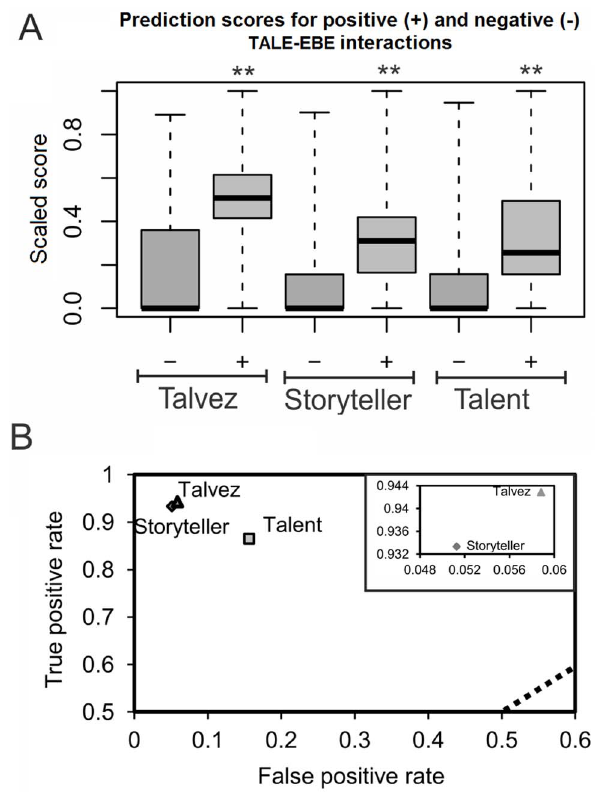
Figure 1. Performances of the EBE prediction software in the TALE-EBE validation set. ( A ) Boxplot showing the median (thick line), the lower and upper quartiles (box) and the minimum and maximum (whiskers) of the prediction scores for the set of positive ( + ) and negative ( 2 ) control TALE-DNA interactions using three programs for EBE prediction. Scores were scaled down according to the maximum score on the set to facilitate comparison. Talent scores were scaled x 2 1 since they follow an inverse scale relative to the other programs, this transformation maintains data structure. ** Indicates significant positive vs. negative differences (one-tailed t-test p-value , 0.001). ( B ) ROC graph showing the true positive and false positive rate of the three EBE predictors based on validation set screenings. Dashed line indicates the theoretical performance of a random classifying program where true positive rate=false positive rate. The inset in the upper right corner shows the rates for Talvez and Storyteller at a higher scale to highlight the differences between the two